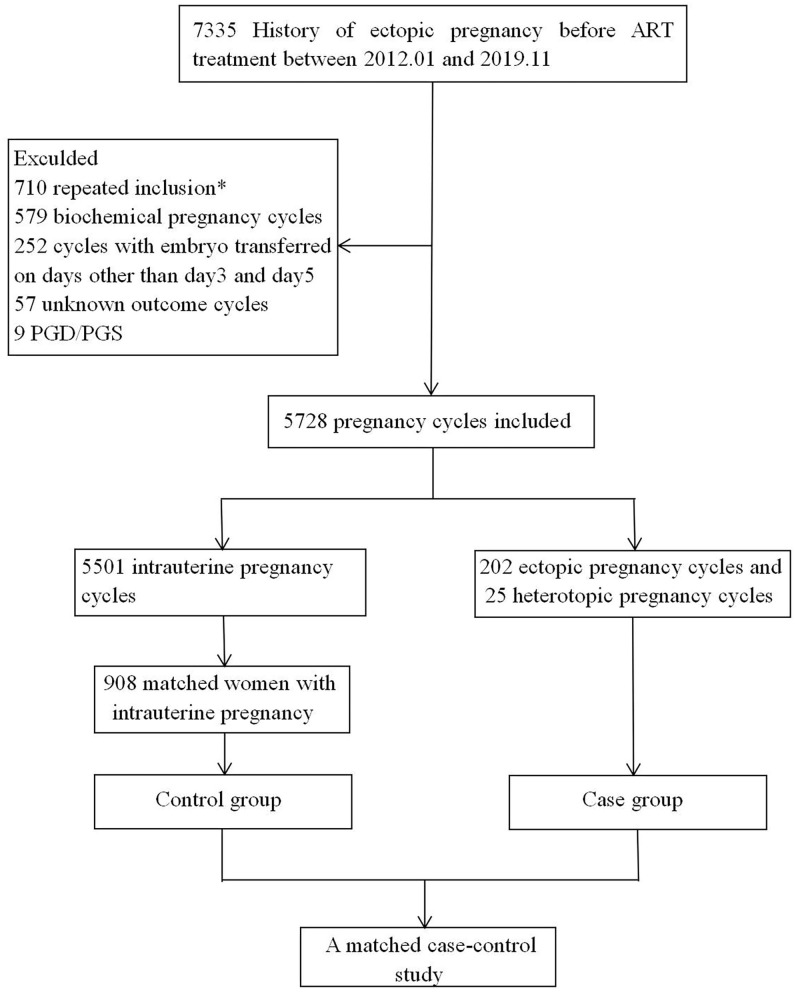
Cycles selection flowchart. *In the case of multiple cycles of clinical pregnancy after ART, bring into the first cycle.